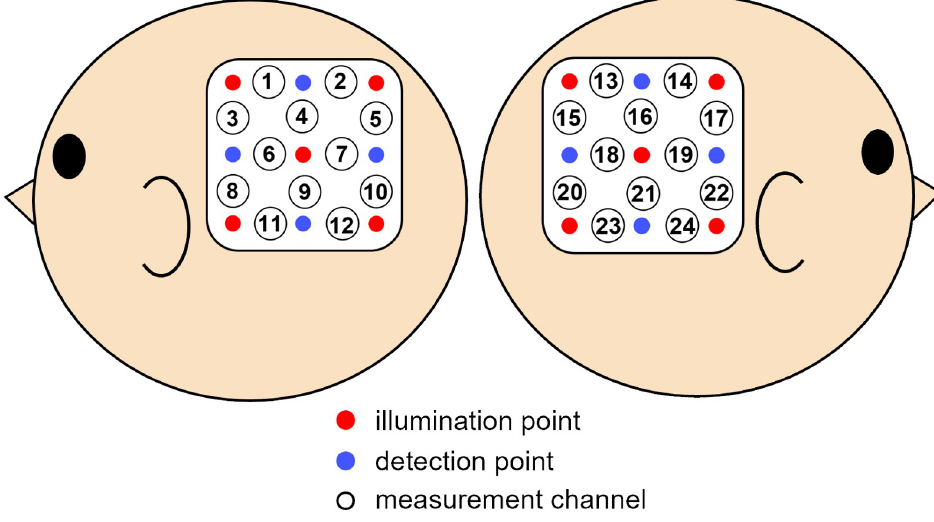
Fig 4. Locations of the measurement channels. The probes were placed on the left and right temporal areas centering at T5 and T6 of the international 10–20 system. The blue circles represent for detector, and the red circles represent for emitter. Each number correspond to the measurement